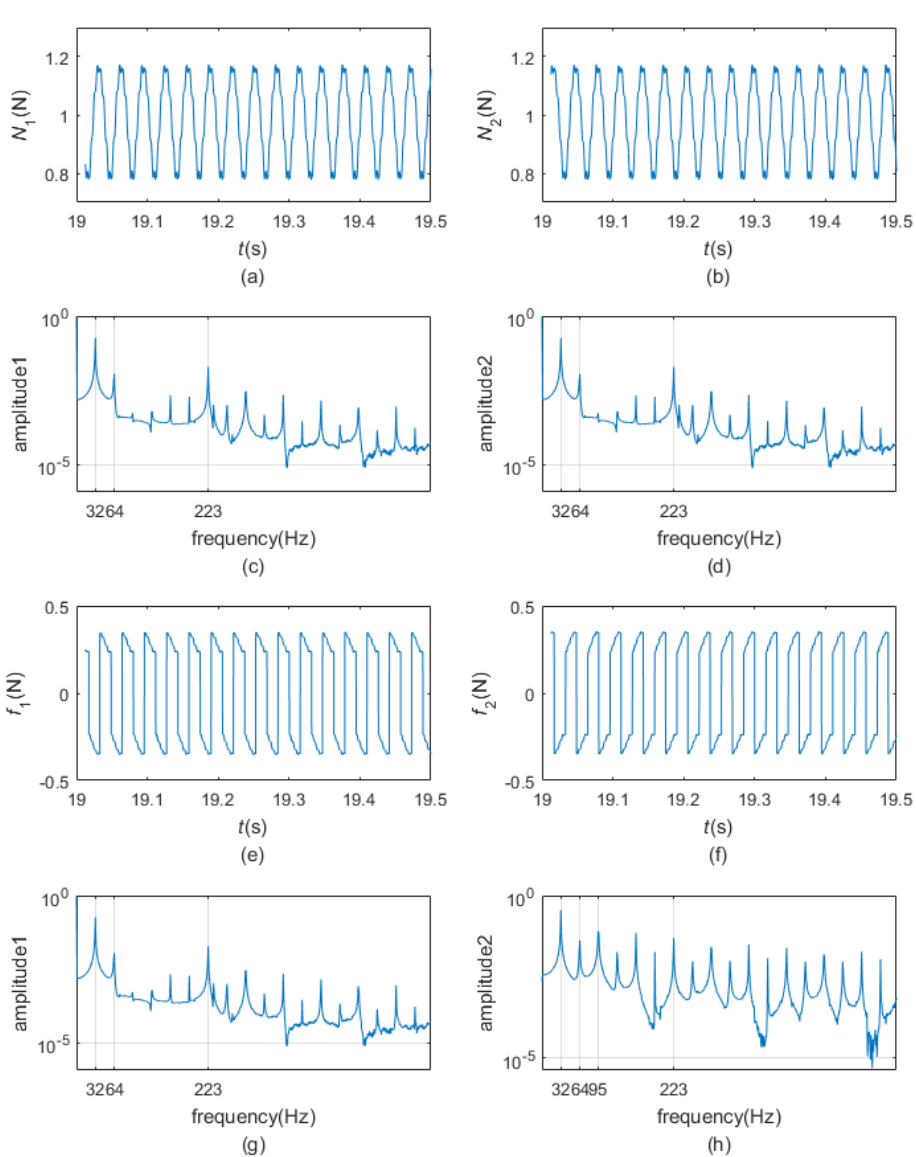
Figure 9. The normal contact forces and friction forces versus time t curves ( a , b , e , f ); and frequency spectrums of the normal contact forces and friction forces ( c , d , g , h ).